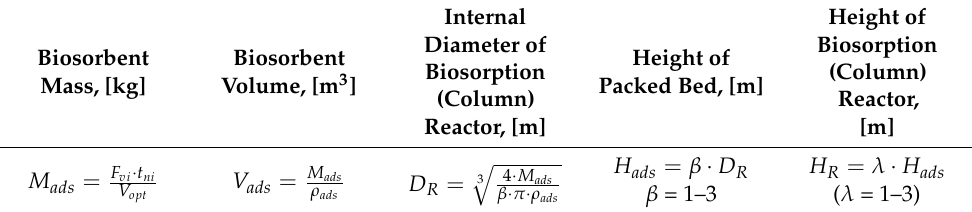
Table 1. Relations used in the experimental design of the biosorption (column)